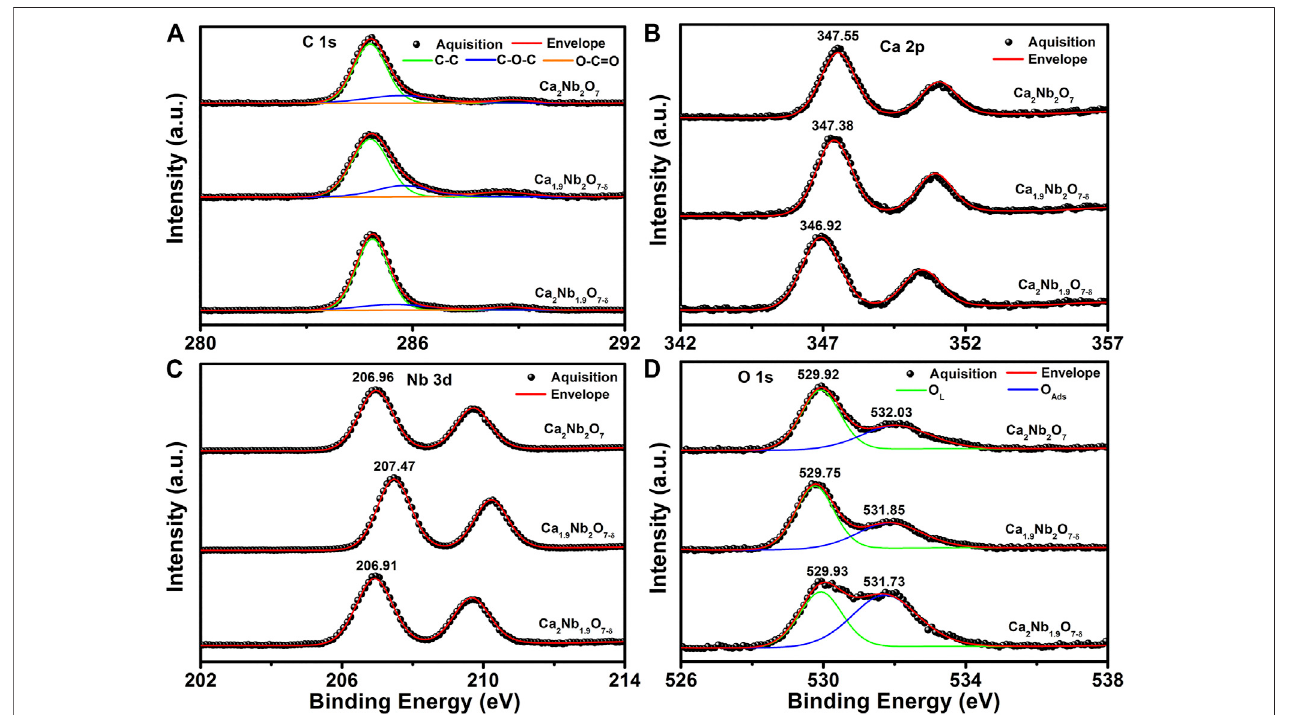
FIGURE 2 | C 1s (A) , Ca 2p (B) , Nb 3d (C) and O 1s (D) core level XPS for the Ca 2 Nb 2 O 7 , Ca 1.9 Nb 2 O 7- δ and Ca 2 Nb 1.9 O 7- δ fi lms.